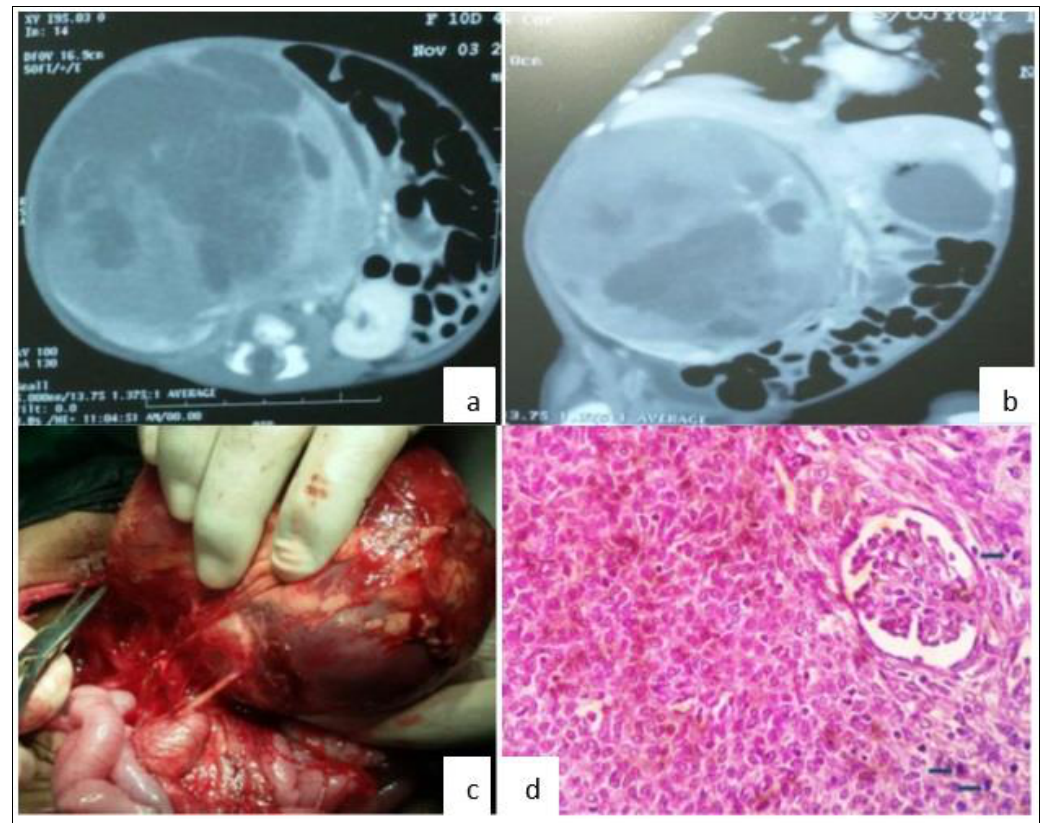
Figure 1: (a) Computed tomography(CT) abdomen - axial image showing large tumor, heterogeneously enhancing with areas of necrosis arising from right kidney displacing vessels and crossing midline. The left kidney is normal. (b) Coronal image showing large renal mass compressing the liver (c) Right side Radical nephrectomy- Intraoperative picture (d) Histology specimen suggesting congenital mesoblastic nephroma, cellular type entrapping the normal glomerulus of kidney. Arrows showing the numerous mitotic